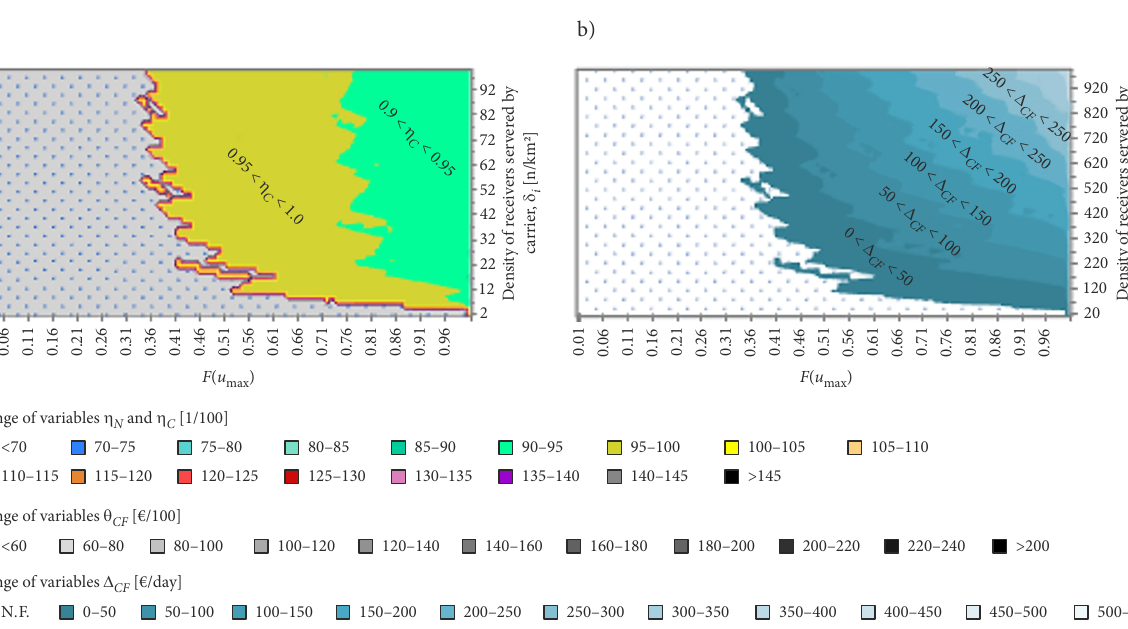
Figure 8. h E , C ratio with MinFare criterion: a – results in Scenario 2.1 ( C CF = 9 m 3 ); b – results in Scenarios 2.2 ( C CF = 2.16 m 3 ) and 2.3 ( C CF = 1.2 m 3 )